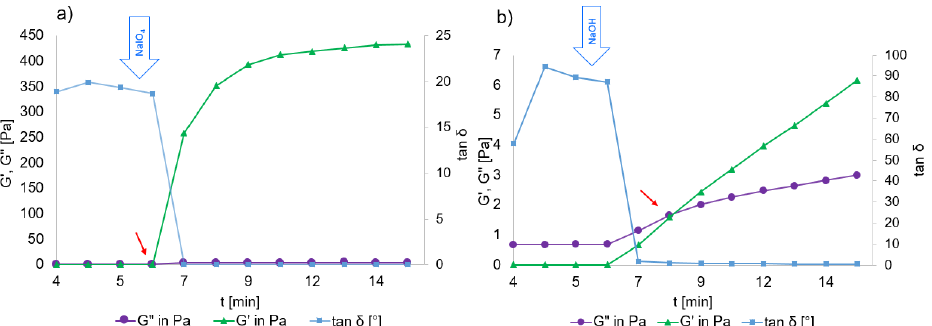
Figure 4. Rheological characterization of the initial crosslinking kinetics of HA-Dop (DS 9%) by NaIO 4 ( a ) and by NaOH ( b ) in oscillation mode with a constant frequency of 1 Hz. The cross-linker was added at 5.5 min after the start of the measurement. Red arrows indicate gelation points (crossing of G ′ with G ′ and decrease of tan δ to below 1).